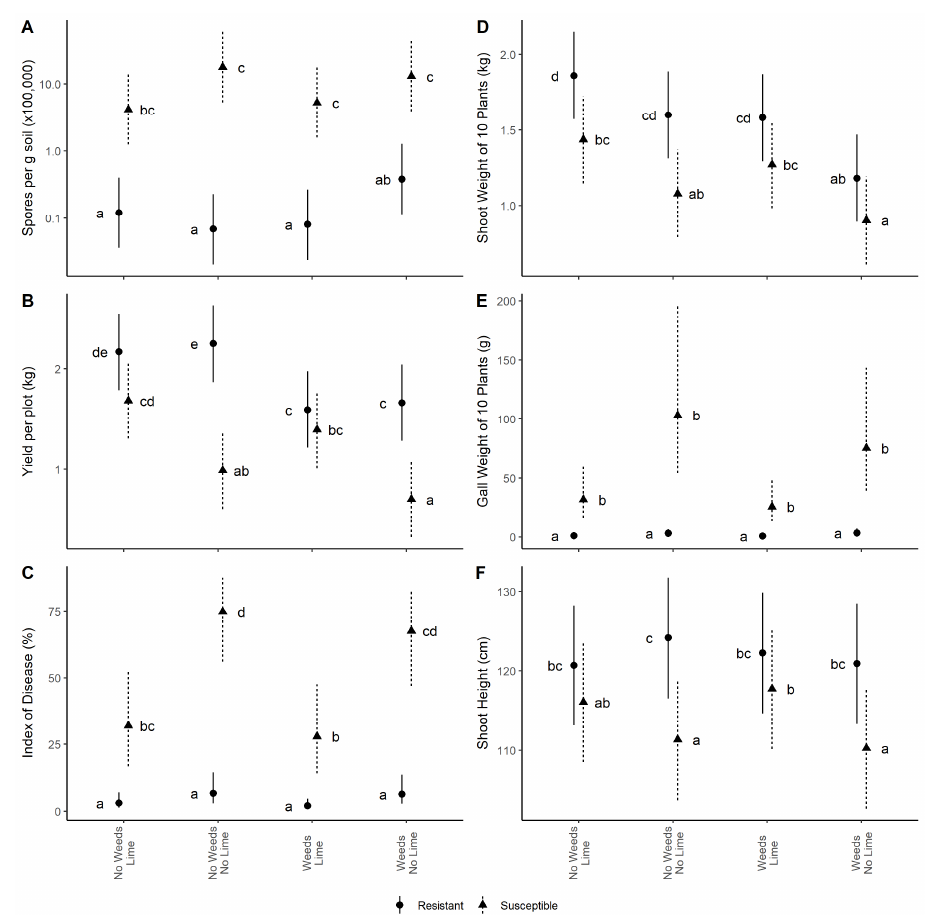
Figure 1. ( A ) Amount (spores) of Plasmodiophora brassicae in the soil, ( B ) canola yield, ( C ) index of disease, ( D ) shoot weight, (E ) gall weight, and ( F ) shoot height in field plot experiments conducted at three field sites in Edmonton, AB, in 2018 and 2019. Differences in means are denoted by different letters at p < 0.05. The whiskers represent the standard errors of prediction × 1.96.